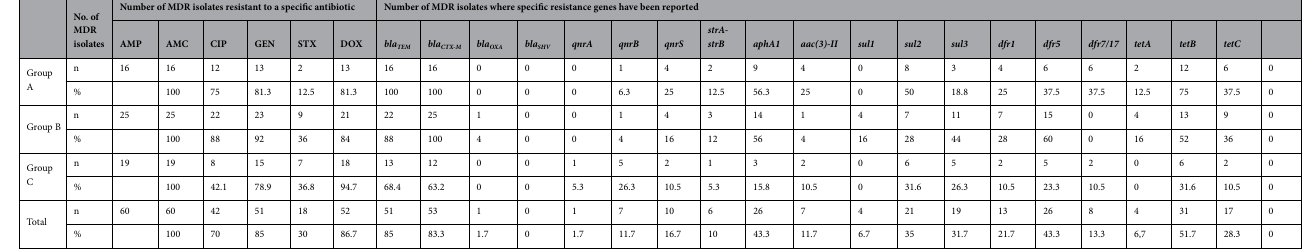
Table 2. The prevalence of the resistance genes among multidrug resistant E. coli isolates obtained from poultry litter (Group A), cloacal swabs (Group B) and poultry meat (Group